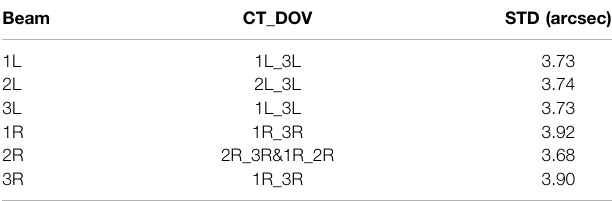
TABLE 8 | Statistical information of recalculation ATVD prime components. Beam